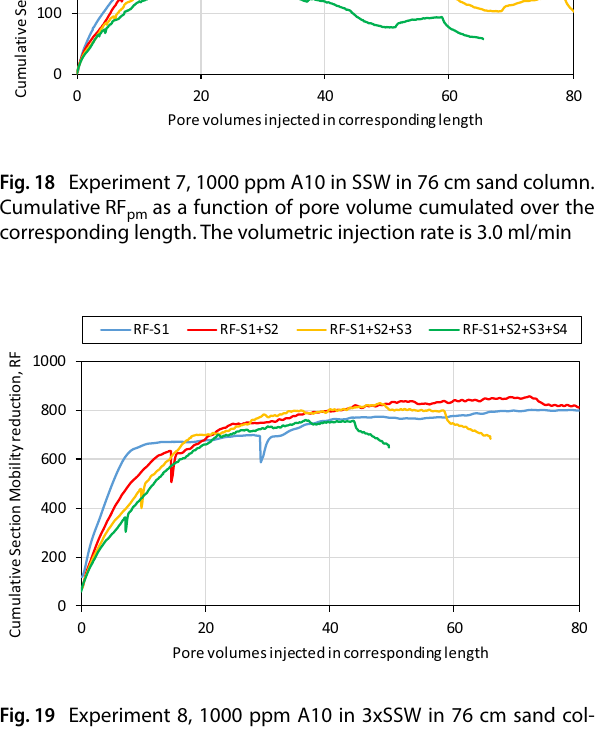
Fig. 19 Experiment 8, 1000 ppm A10 in 3xSSW in 76 cm sand col- umn. Cumulative RF pm as a function of pore volume cumulated over the corresponding length. The volumetric injection rate is 3.0 ml/min